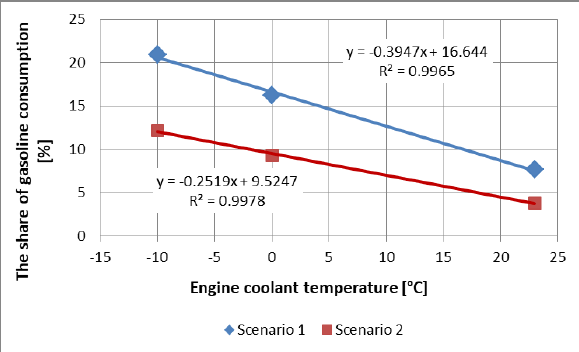
Figure 6: Average values of the share of gasoline mass consumption [%] in total fuel consumption for various engine initial temperatures and different vehicle use scenarios.